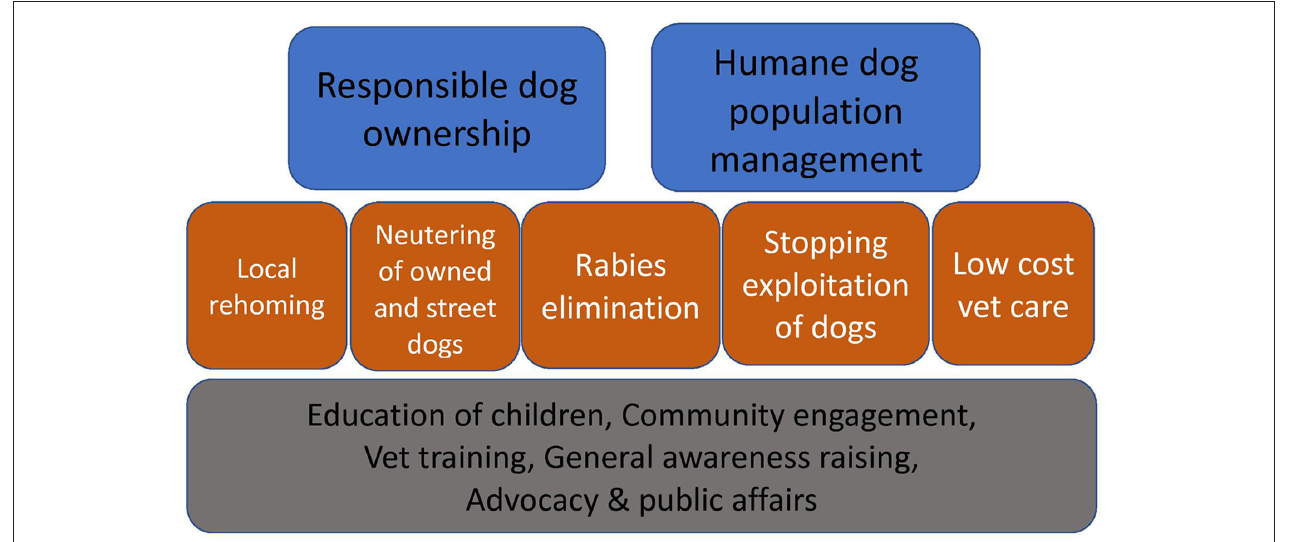
figure 2 | Dogs Trust Worldwide Theory of Change